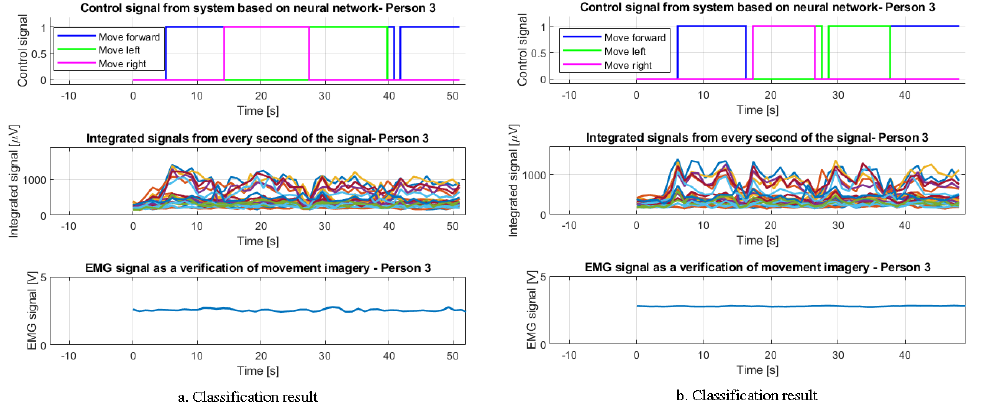
Figure 20. Observation of the signal classification and verification results—Person